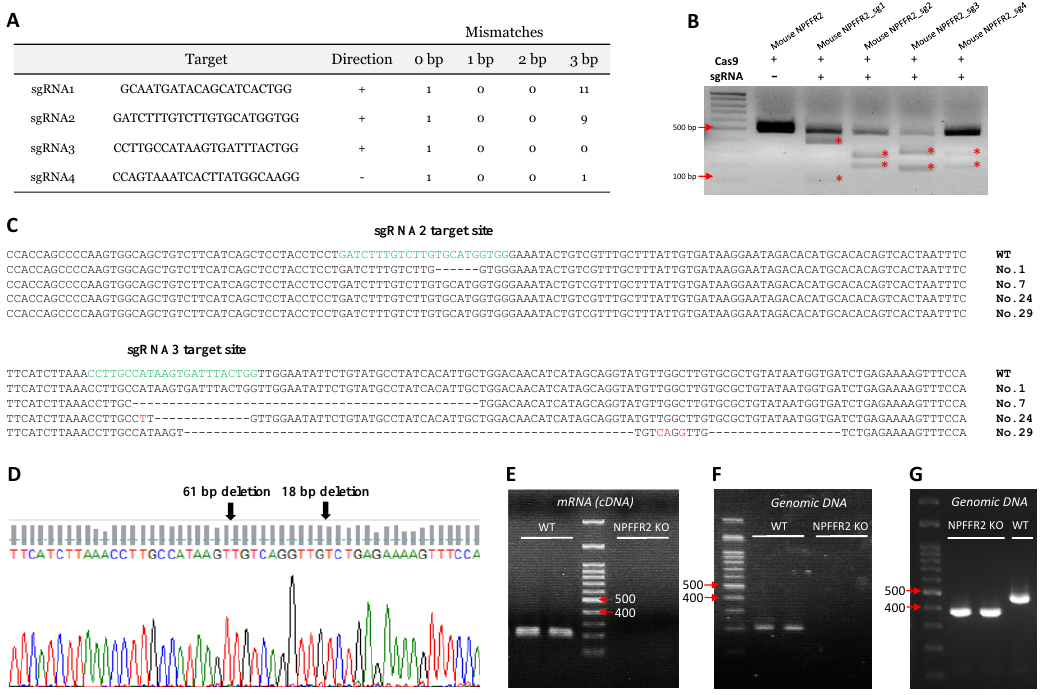
Figure 1. Generation of neuropeptide FF receptor 2 (NPFFR2) knockout (KO) mice. NPFFR2 KO mice were generated by CRISPR/Cas9 technology. ( A ) The sequences of four tested sgRNAs. ( B ) The gene editing efficiencies of sgRNAs were tested by incubating with Cas9 protein and PCR amplicons of the mouse NPFFR2 locus. *, indicates the digested segments. ( C ) DNA sequences of NPFFR2 KO F0 mice (Numbers 1, 7, 24, and 29). ( D ) The genome sequencing map of number 29, which was used in this study as the founder for NPFFR2 KO mice. ( E ) The genomic DNA PCR products of wild-type (WT) and NPFFR2 KO mice (No. 29). ( F ) The cDNA PCR products of WT and NPFFR2 KO mice (No. 29). ( F ) The genotyping PCR products of WT and NPFFR2 KO mice (No. 29). Red arrows, indicate the specific bp of DNA markers.